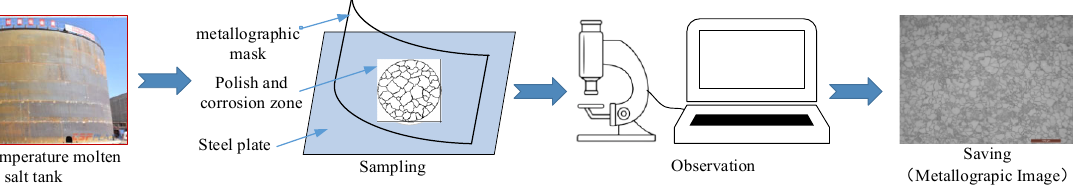
Figure 1. Diagram of metallographic examination procedure.